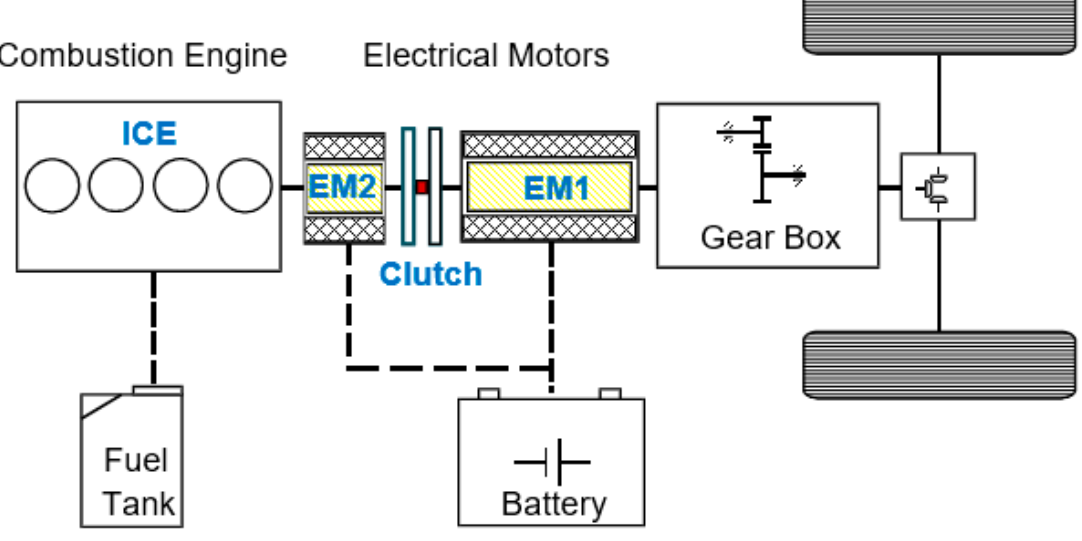
Figure 1. The 2021 Hyundai Parallel HEV.